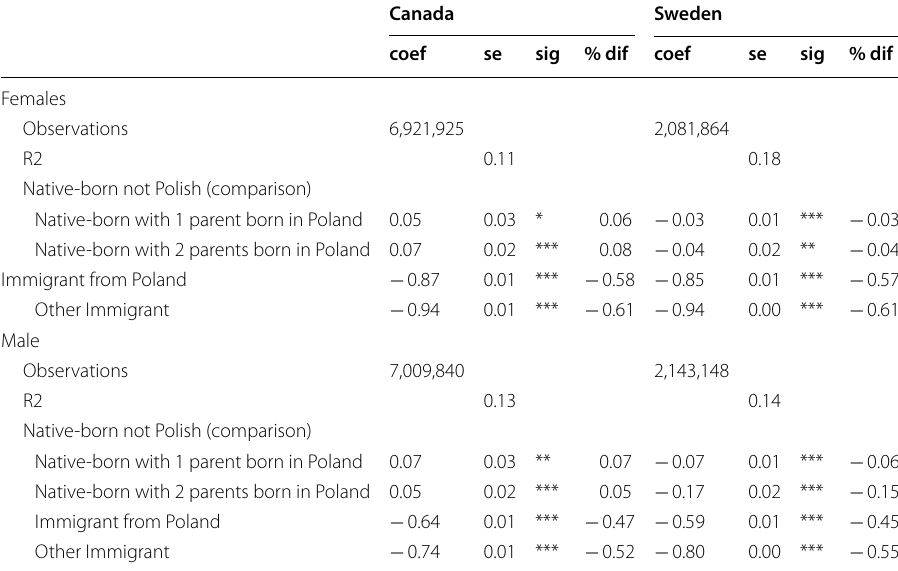
The 2016 Census of Canada is a 25% sample of Canadian households. As per Statistics Canada requirement we show the weighted number of observations Significance: *0.1; **0.05;